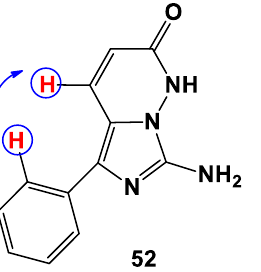
Figure 2. Key interactions concerning compound 52 in the NOESY spectra.